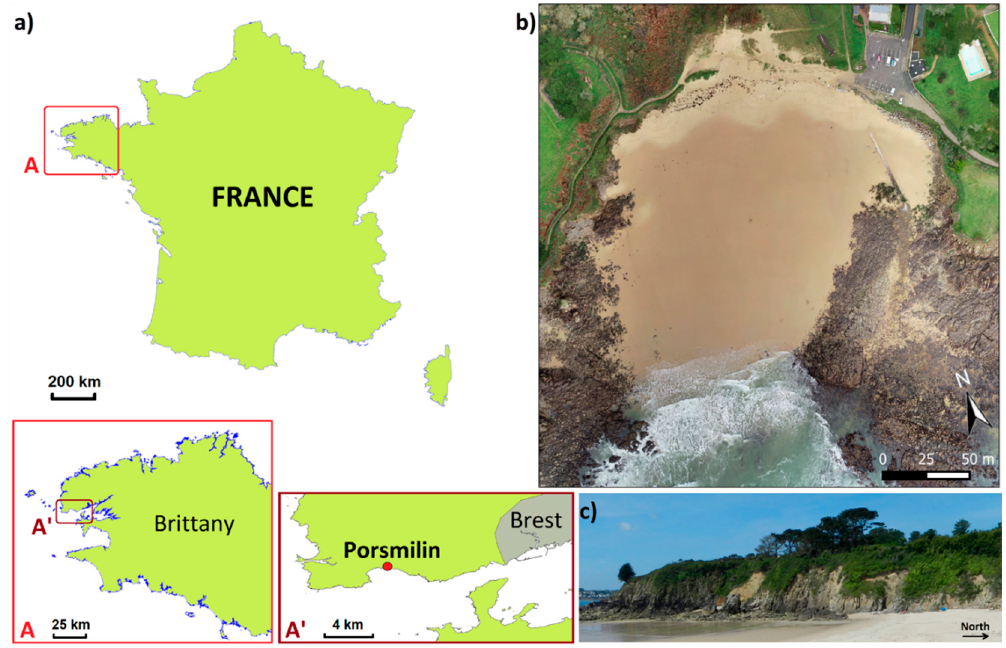
Figure 1. ( a ) Localization of the study area of Porsmilin beach at the entrance of the Bay of Brest in Brittany (France). ( b ) Orthophotograph of Porsmilin beach (computed from drone images). ( c ) Western cliff.